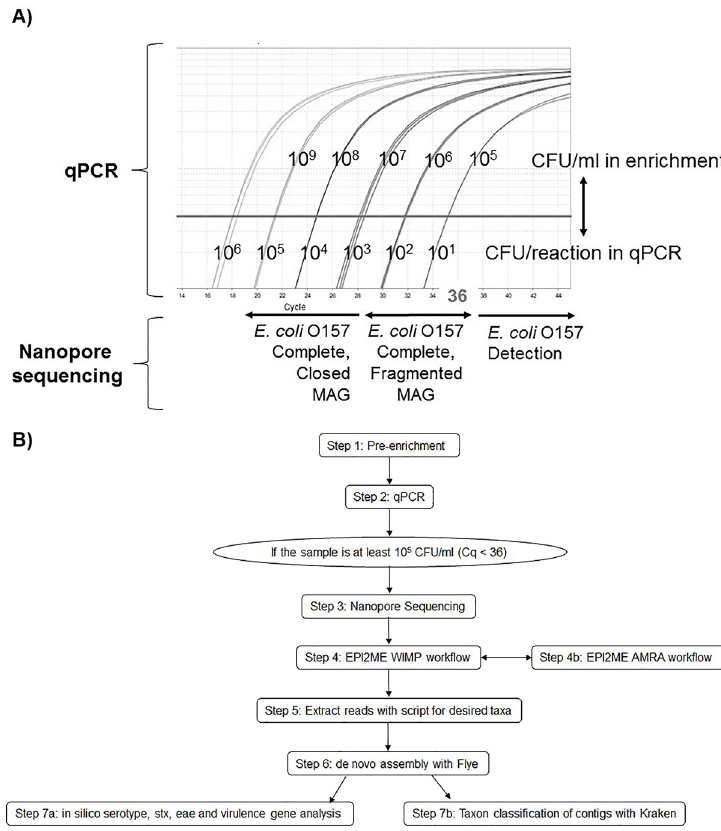
Fig 4. STEC detection and classification by combined qPCR and nanopore sequencing approach. A) Direct comparison of quantitative qPCR detection with de novo assembly limits by nanopore sequencing informs detection and classification of STECs. B) Pipeline for detection and classification of STECs in enriched irrigation water using nanopore sequencing and EPI2ME cloud-based services to identify reads of a desired taxa for de novo assembly with Flye and in silico